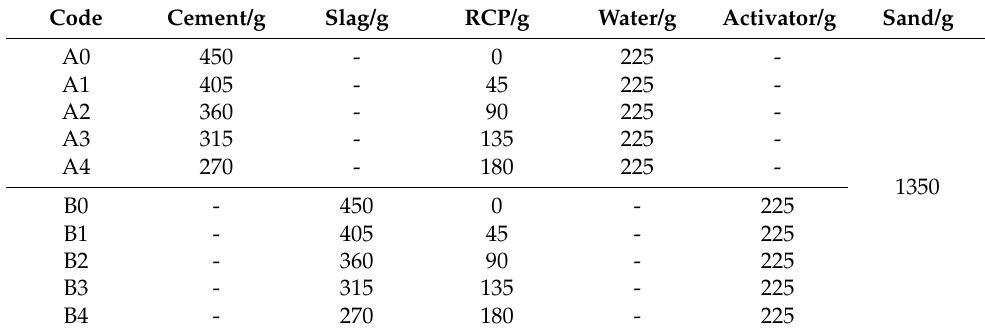
Table 2. Mix proportion of the specimens, g/pot.